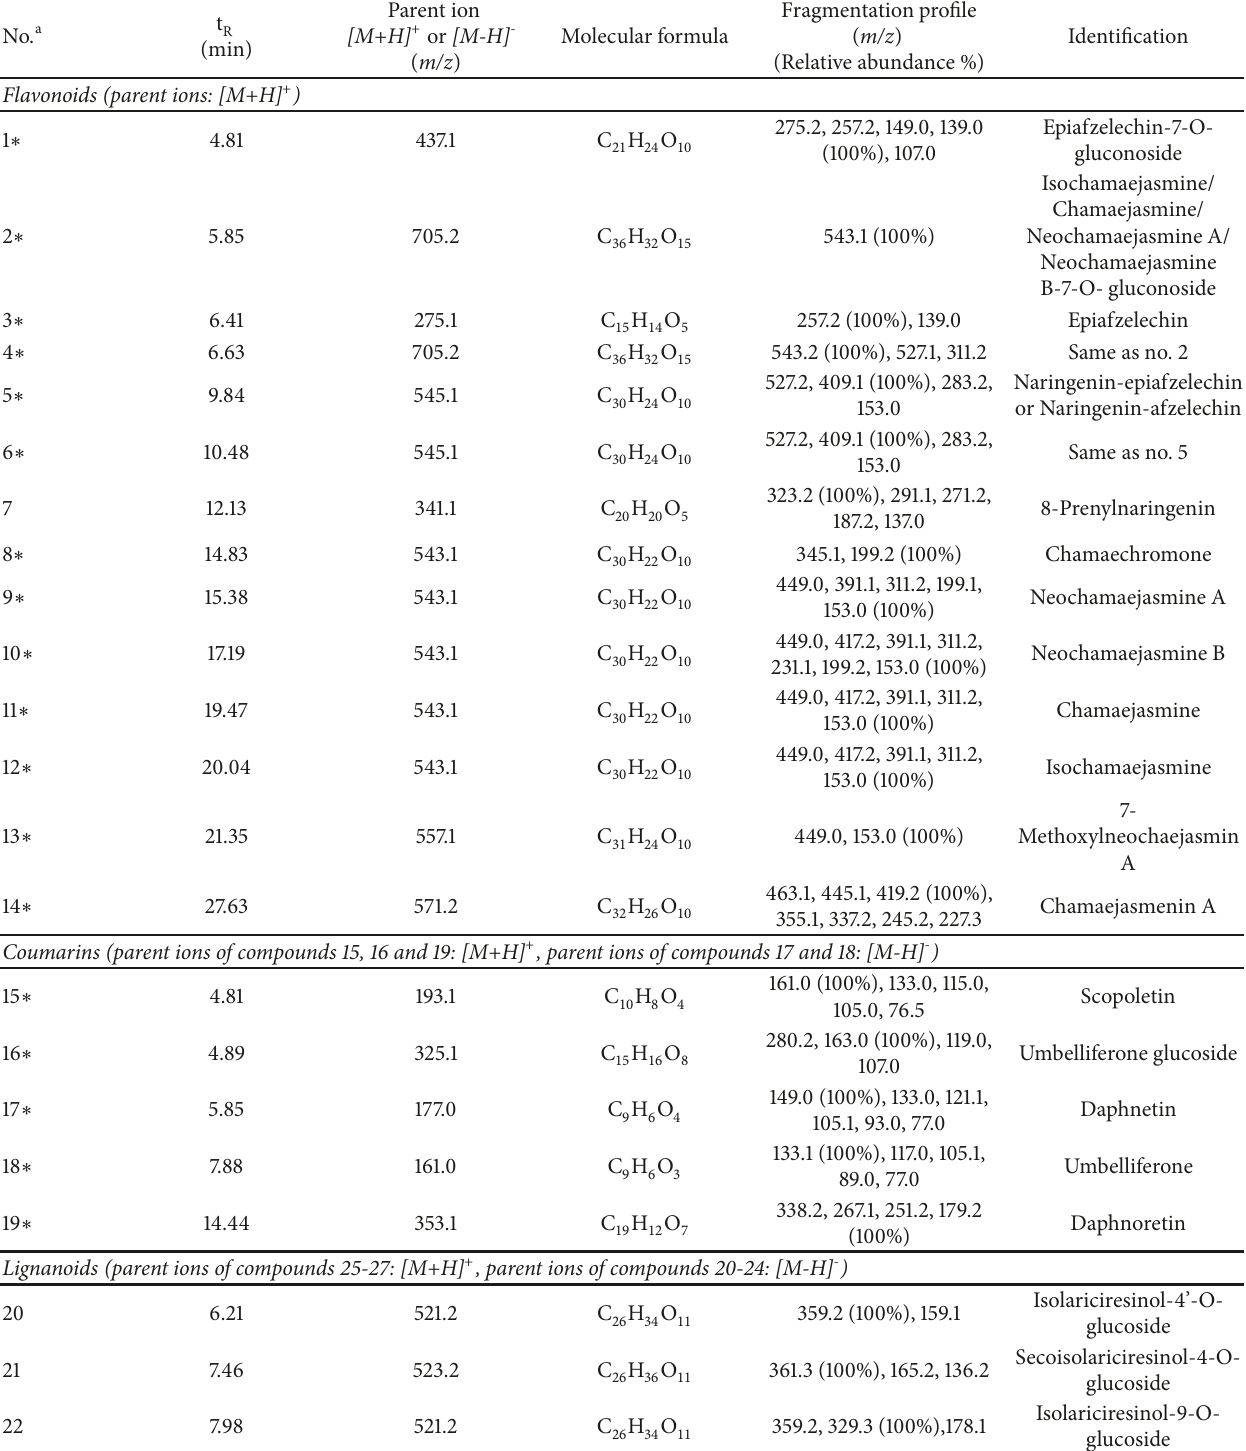
Table 1: Identification of compounds in